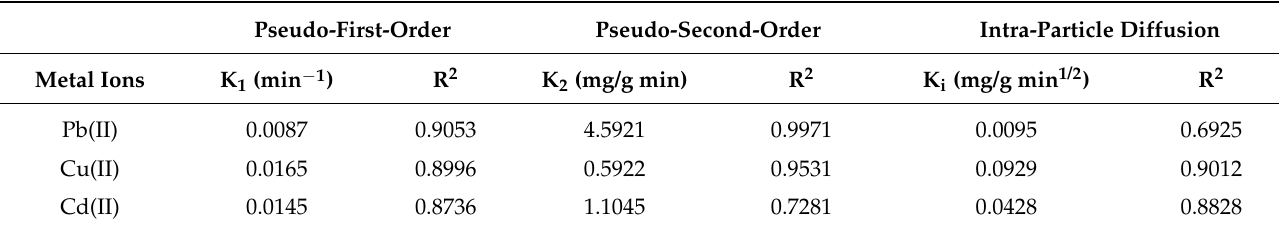
Table 2. Dynamic parameters for the adsorption of metal ions on the